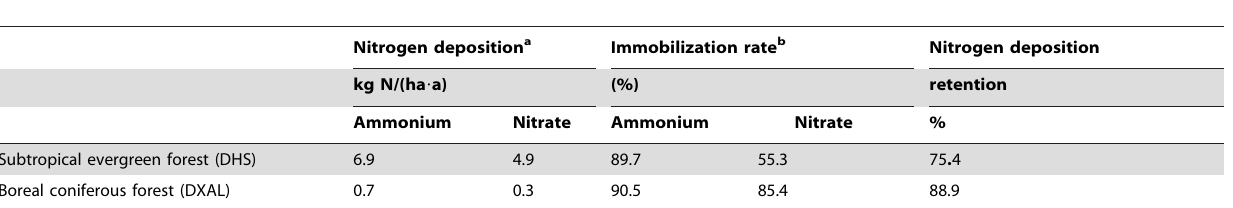
Table 3. Nitrogen deposition and retention in the two old growth forest ecosystems during the experimental period.